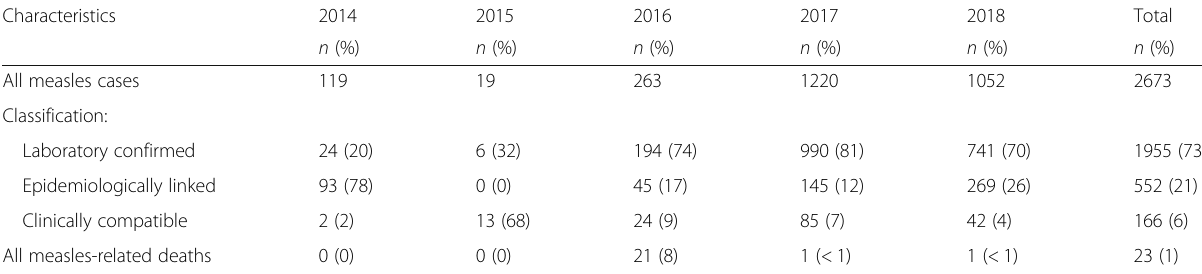
Table 1 Annual reported measles cases, stratified by laboratory confirmed, epidemiologically linked, and clinically compatible and annual reported measles-related deaths in Myanmar: 2014 – 2018 Characteristics